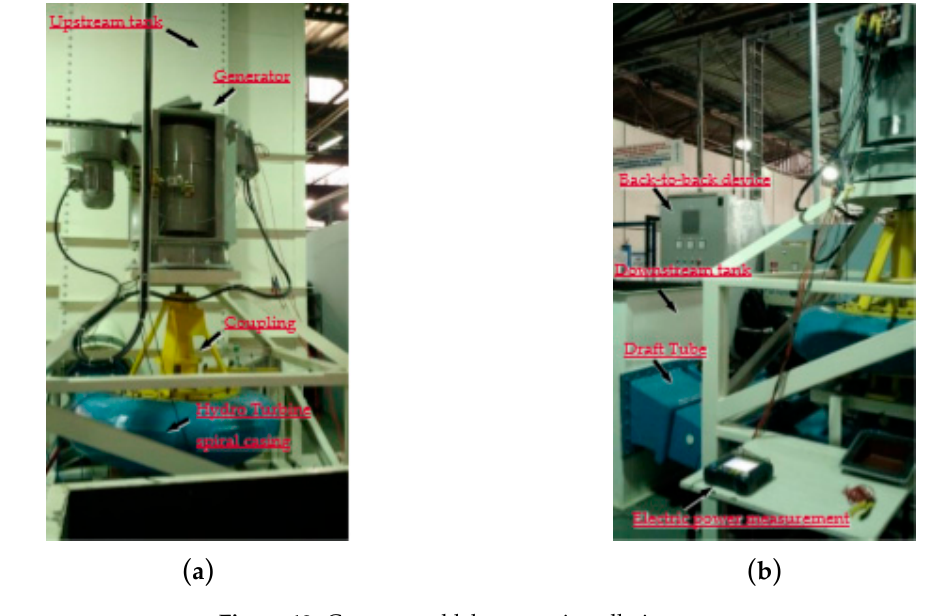
Figure 12. Constructed laboratory installation setup.